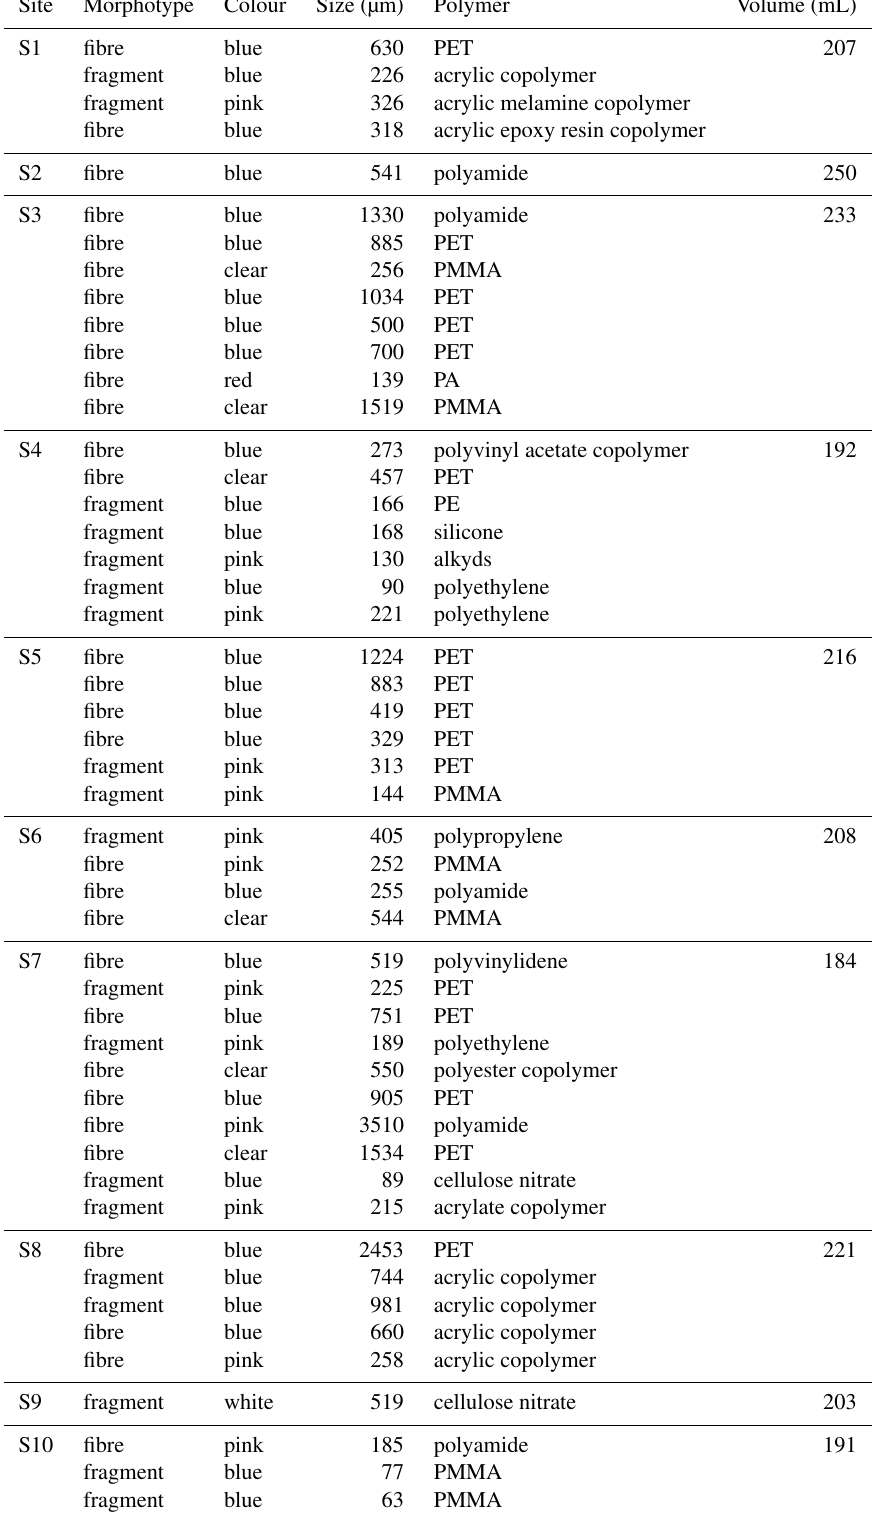
Table A2. Characteristics of microplastics identified and sample volume. As discussed in the text, “blue” includes blue, black and navy. “Size” indicates the width for fragments and length for